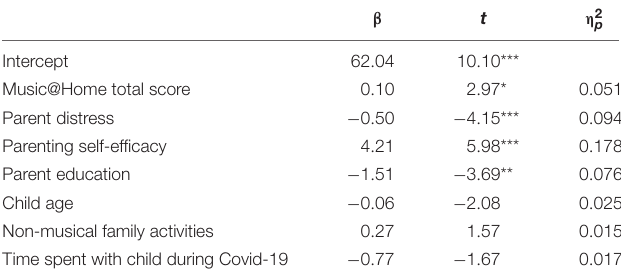
TABLE 6 | Parent-child attachment